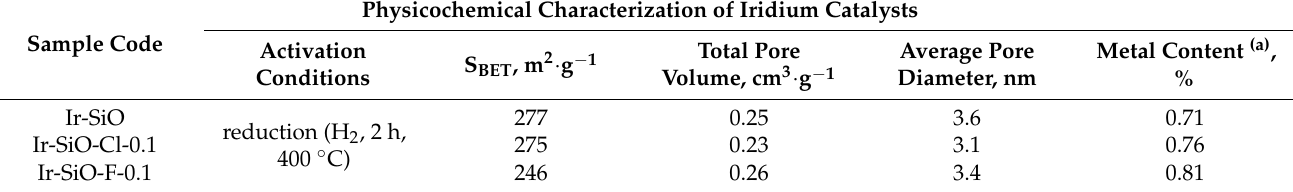
Table 2. Physicochemical properties of iridium